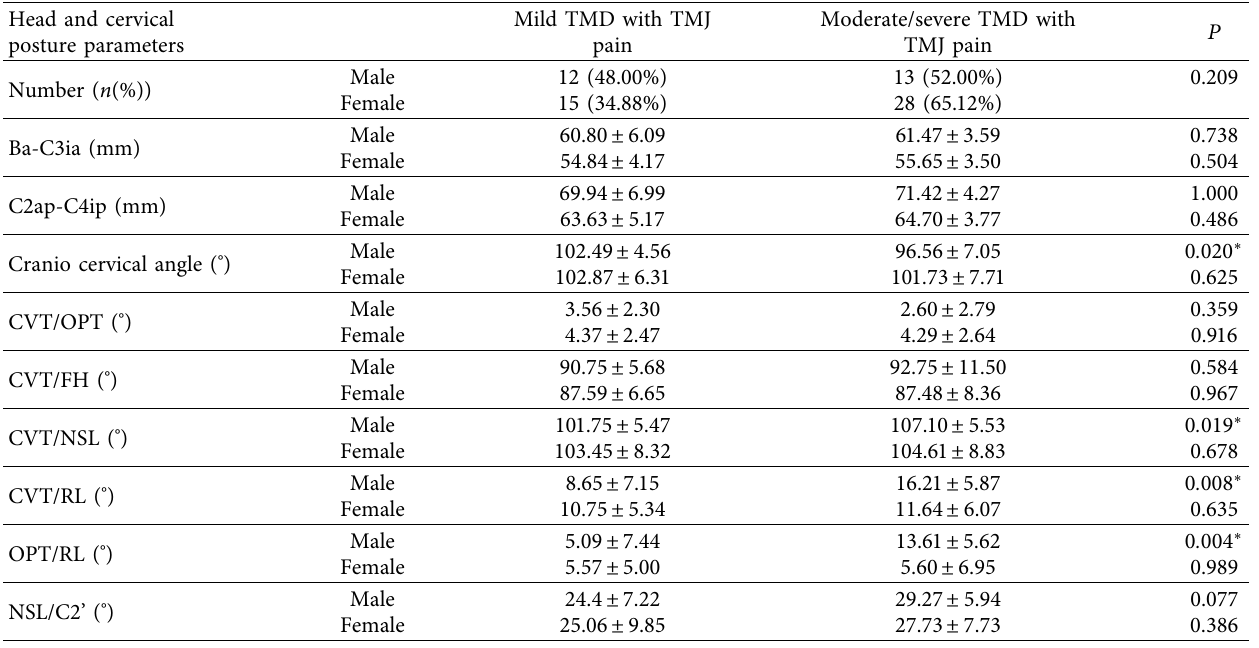
Table 5: Head and cervical posture parameters of mild TMD patients with TMJ pain and moderate/severe TMD patients with TMJ pain. Head and cervical posture parameters